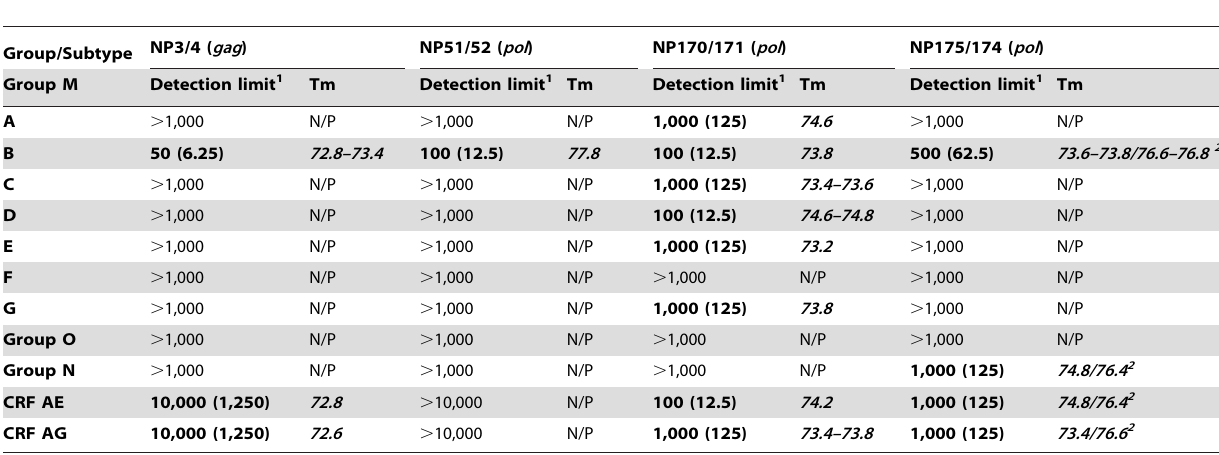
Table 3. Sensitivity of four HIV-1 specific primer sets selected for the real-time PCR array in testing with FDA/CBER analytical HIV-1 broad spectrum panel.